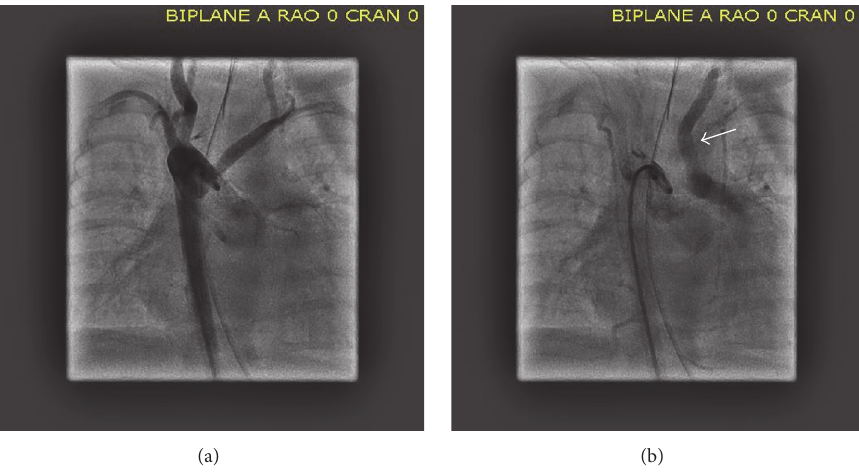
Figure 3: (a) Camera in the AP plane. An angiogram (early phase) is performed in the transverse aorta, revealing a right aortic arch with aberrant origin of the left subclavian artery and absence of the left common carotid artery. (b) Camera in the AP plane. An angiogram (late arterial phase) reveals retrograde opacification of the left common carotid artery (arrow) draining into the left pulmonary